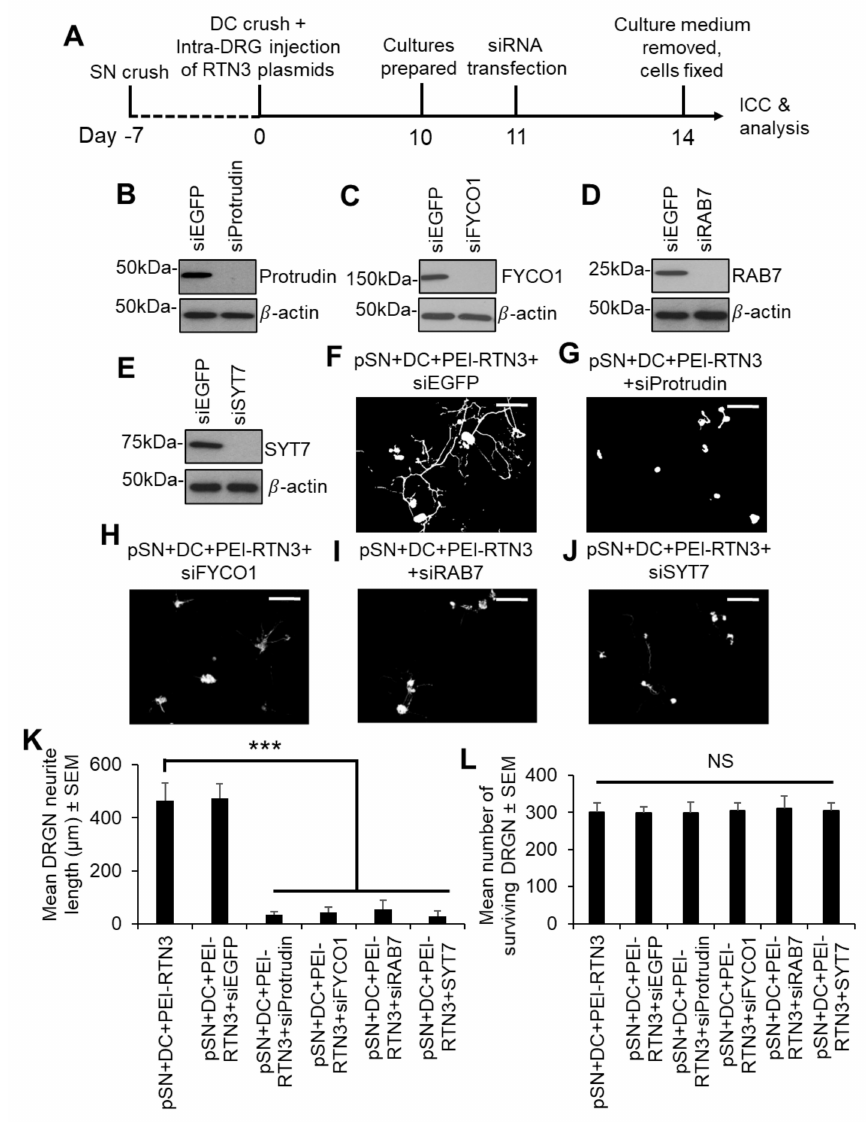
Figure 5. Knockdown of Protrudin and its interactors attenuates RTN3-induced DRGN neurite outgrowth. ( A ) Timeline for experimental analysis of Protrudin and its interactors in RTN3- overexpressed DRGN. Representative Western blots to confirm knockdown of ( B ) Protrudin, ( C ) FYCO1, ( D ) RAB7 and ( E ) SYT7. β -actin is used as a protein loading control. Representative images to show neurite outgrowth in ( F ) RTN3 overexpressed DRGN controls and after knockdown of ( G ) Protrudin, ( H ) FYCO1, ( I ) RAB7 and ( J ) SYT7 in RTN3-overexpressed cultures. ( K ) Quantification to show attenuation of RTN3-overexpressed DRGN neurite outgrowth by shProtrudin, shFYCO1, shRAB7 and shSYT7. ( L ) DRGN survival remains unaffected by knockdown of Protrudin, FYCO1, RAB7 and SYT7 in RTN3-overexpressed DRGN. n = 9 wells/condition Scale bars in ( F – J ) = 100 µ m. Data are means ± SEM. *** p = 0.0001, one-way ANOVA with Dunnett’s post hoc